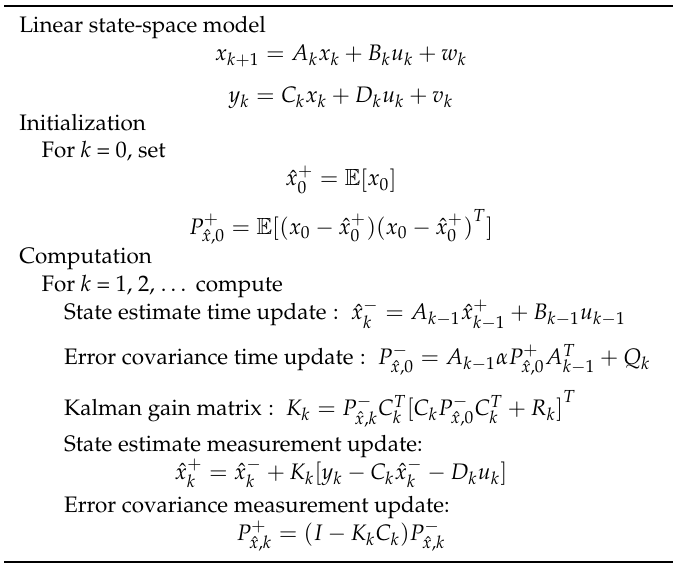
Table 5. Summary of the Fading Kalman filter algorithm [53].